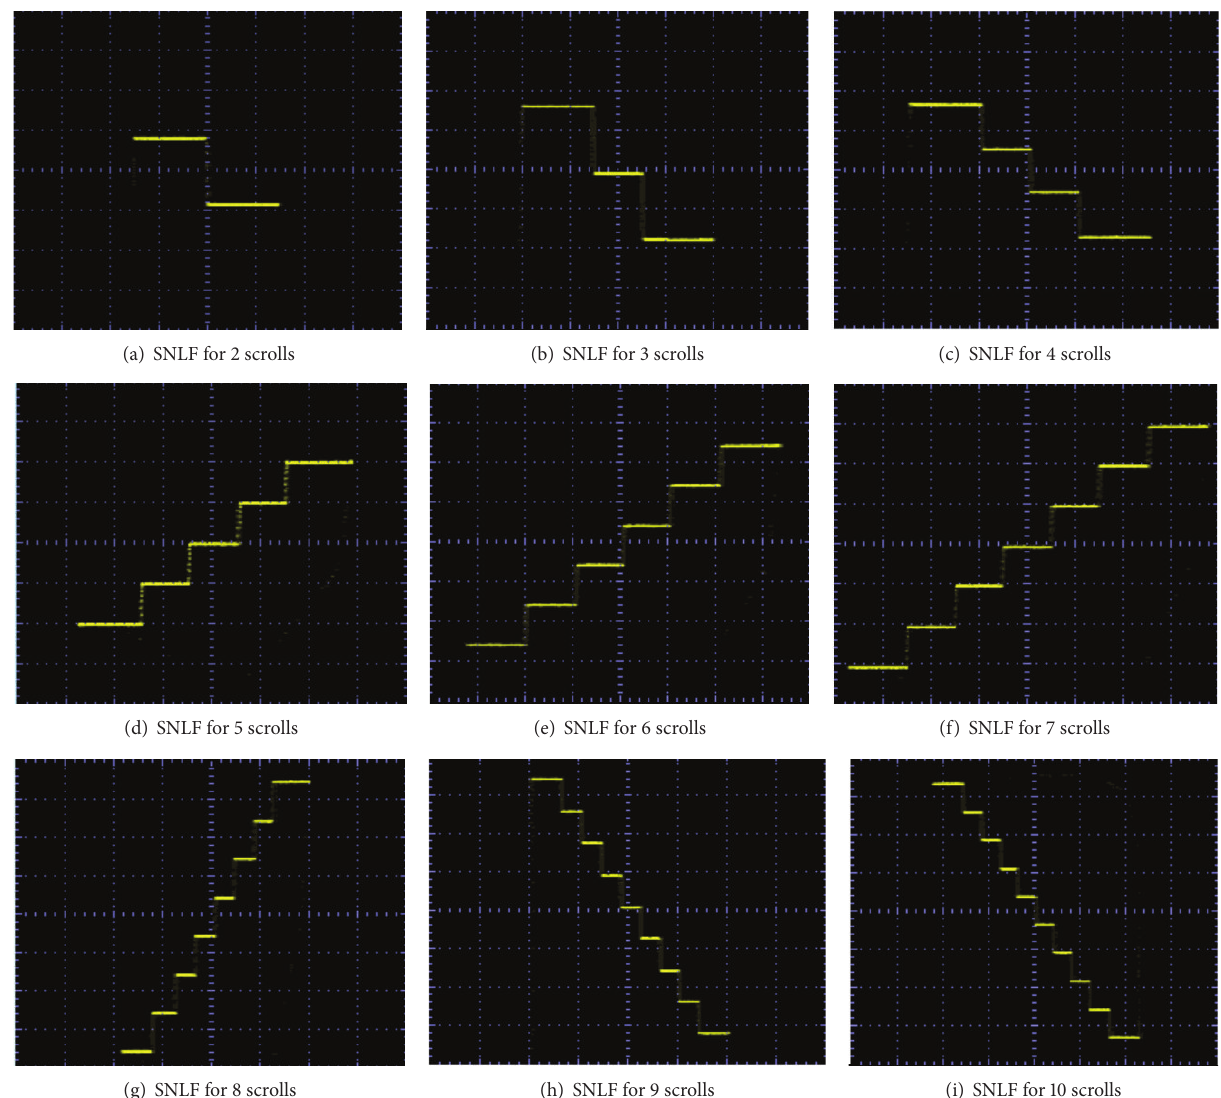
Figure 8: Experimental results of the SNLF for generating from 2 to 10